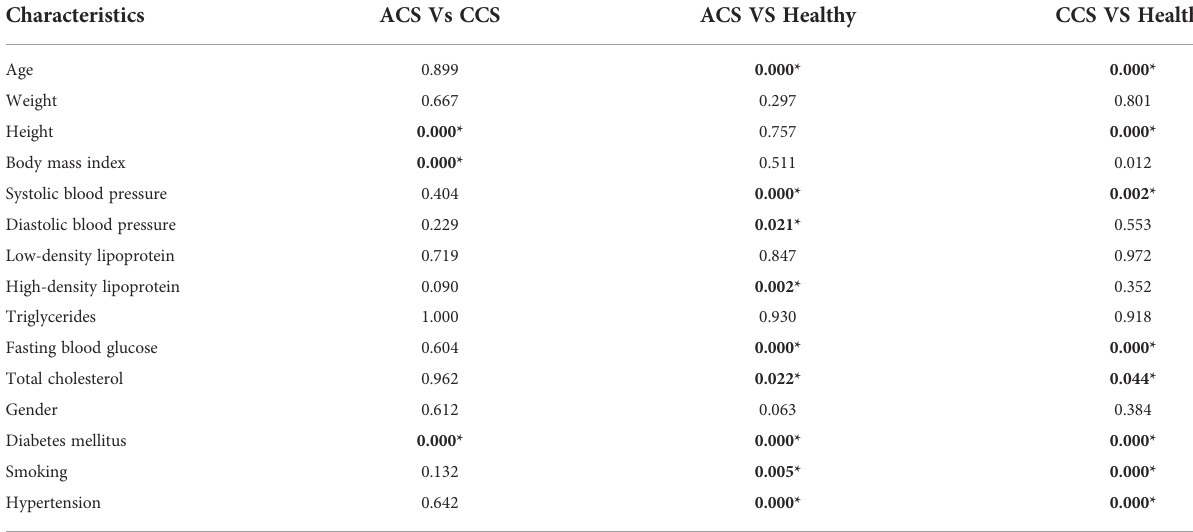
TABLE 2 P-values across Acute coronary syndrome, Chronic coronary syndrome, and Healthy groups.